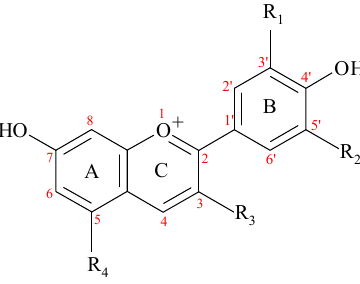
Figure 1. Structure of anthocyanins (R 3 = -OH, R 4 = -OH) and anthocyanidins (R 3 = β - d -glycopyranosyl, R 4 = -OH, anthocyanidin-3- O - β - d -glycopyranosyl; or R 3 = β - d -glycopyranosyl, R 4 = β - d -glycopyranosyl, anthocyanidin-3,5- O - di- β - d -glycopyranosyl) from dietary sources.